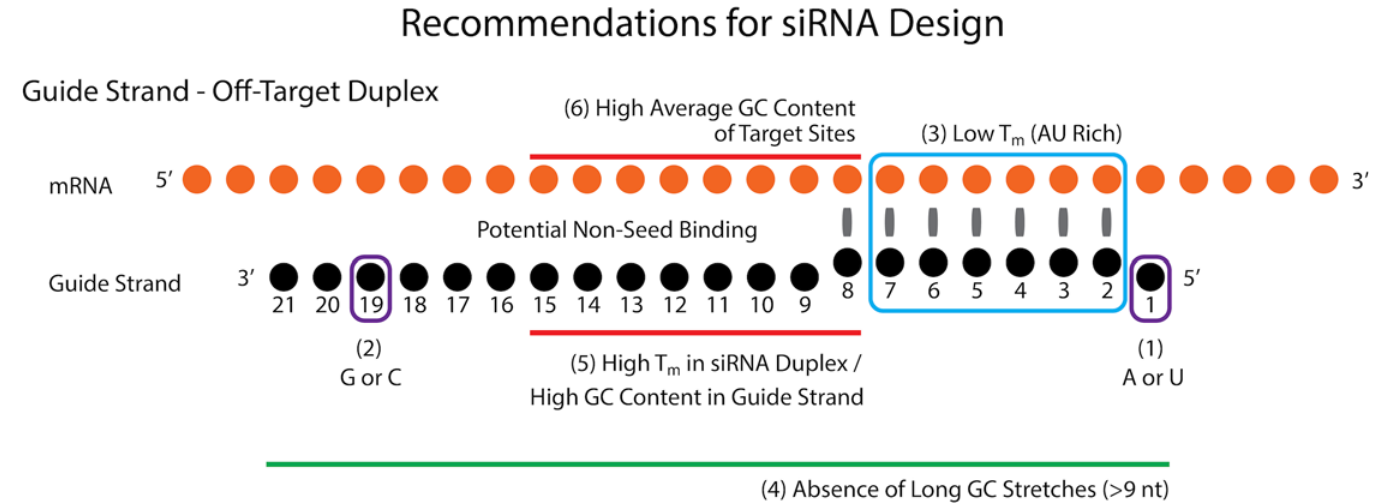
Fig 5. Summary of ‘ highly effective ’ and ‘ off-target effect-reduced ’ design rules for siRNA molecules. Based on our previous analysis and the results shown in Figs 2 – 4, we recommend designing molecules with: (1) A or U at position 1, (2) G or C at position 19, (3) low predicted T m /AU richness at positions 2 – 7, (4) absence of GC stretches longer than 9 nt, (5) high predicted T m in siRNA duplex/high GC content in guide strand at positions 8 – 15, and (6) high average GC content for all off-target sequences corresponding to positions 8 – 15 in the siRNA non-seed region.